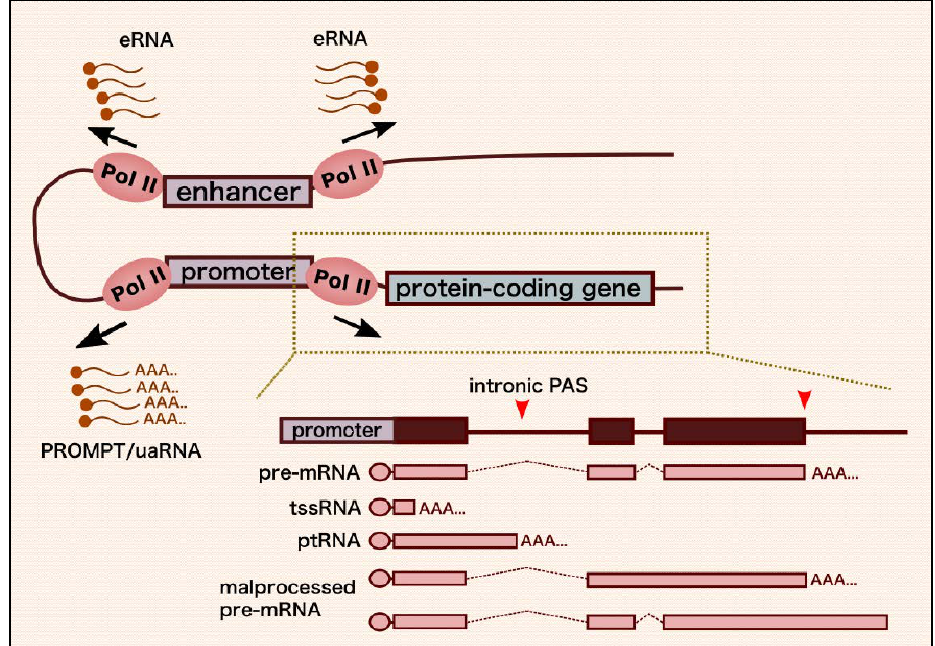
Figure 1. Schematic depiction of Polymerase II transcripts generated from enhancers and gene promoters. Both enhancers and promoters are transcribed bi-directionally and produce various types of transcripts, including messenger RNA precursors (pre-mRNA), transcription start site-associated RNA (tssRNA), prematurely terminated RNA (ptRNA), upstream antisense RNA (uaRNA) or promoter upstream transcript (PROMPT), and enhancer RNA (eRNA). The exosome functions in nuclear RNA surveillance to degrade these RNAs, as well as misprocessed messenger RNA (mRNA) precursors, such as intron-retained and poly(A) signal-mediated cleavage, and polyadenylation-defective pre-mRNAs.